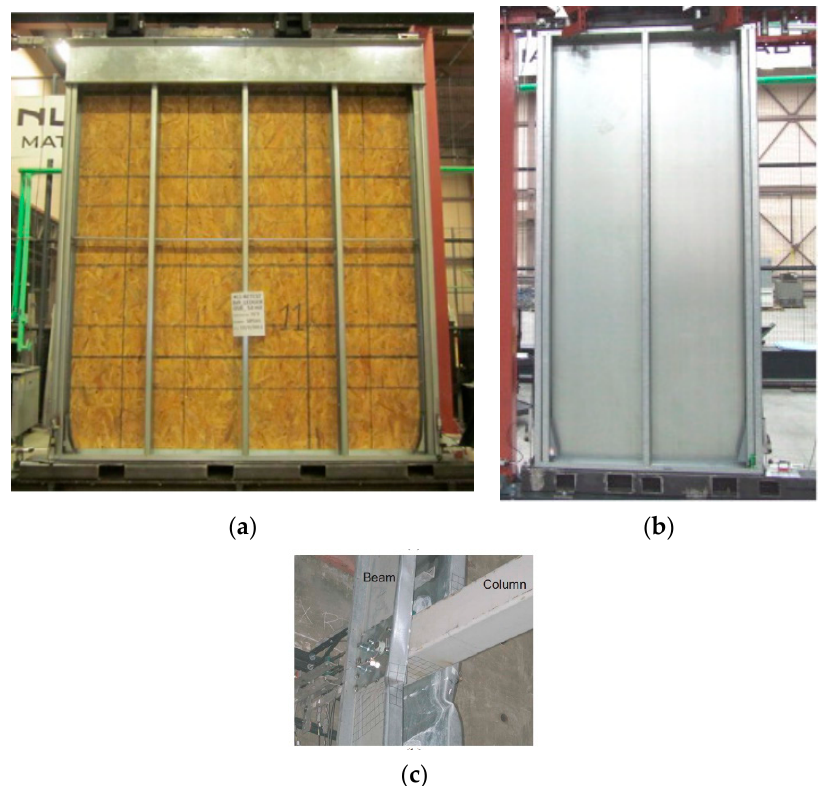
Figure 8. ( a ) CFS light-frame shear walls sheathed with wood structural panels [15]; ( b ) CFS light-frame shear walls with steel sheet sheathing [16]; ( c ) beam-column joint in a CFS special bolted moment frame [17].